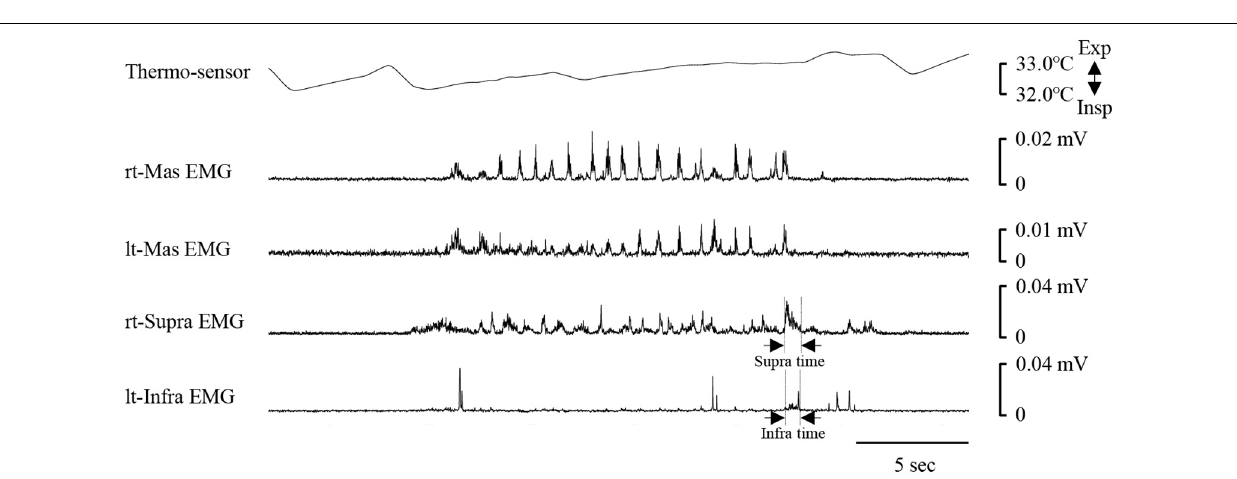
FIGURE 9 | Example of respiratory and electromyography (EMG) recordings in one participant who inhibited her breath during chewing. In this case, no clear period of swallowing apnoea could be identified. Infra time, infrahyoid EMG burst duration; rt-Mas, right masseter; lt-Mas, left masseter; rt-Supra, right suprahyoid, lt-Infra, left infrahyoid; Supra time, suprahyoid EMG burst